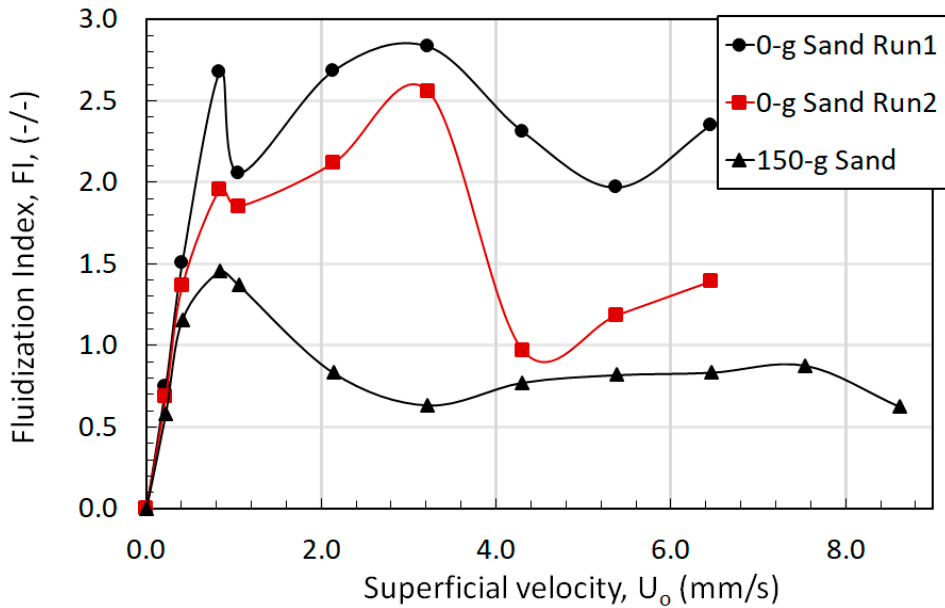
Figure 9. Effect of the addition of external particles on the fluidization hydrodynamics of the monocomponent bed and mixed bed of calcium hydroxide and sand.